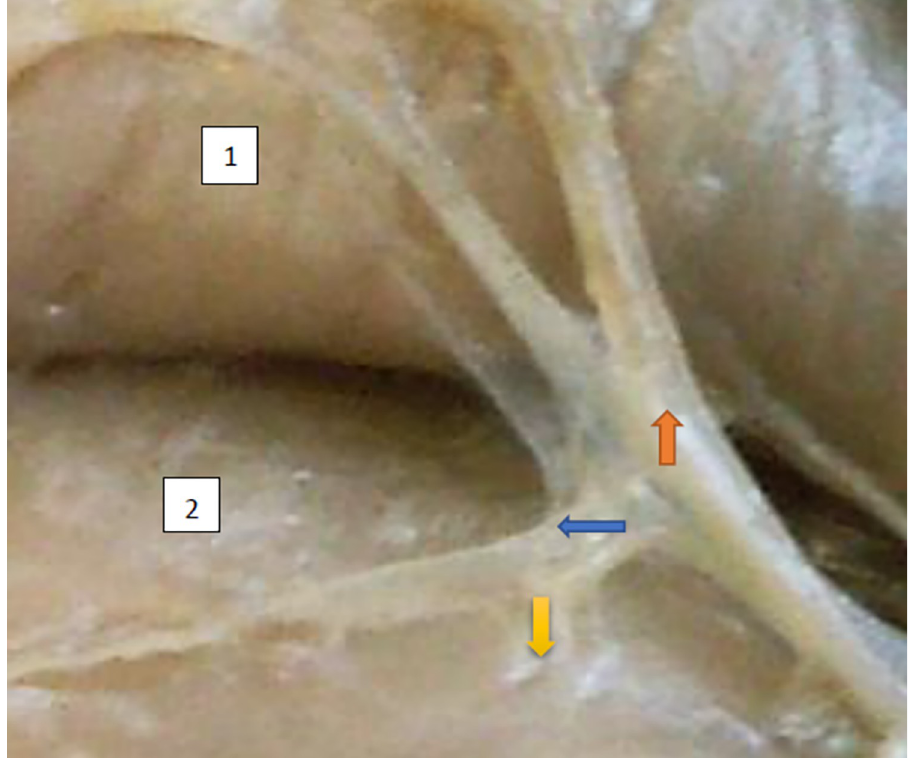
Fig 1. Superior gluteal nerve, tree type, morphological age 157–23–VI, v–tub 182, v–pl 258, mass 450, female sex, magnification 20x, 1– gluteus medius muscle, 2– gluteus minimus muscle, red arrow–branch gluteus medius muscle, yellow arrow–branch to gluteus minimus muscle, blue arrow–branch to tensor fasiae latae muscle (branch to tensor fasiae latae muscle is better visible in Fig 2).